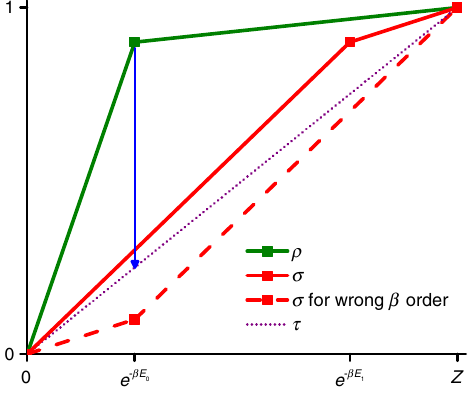
FIG. 7. Partial level thermalizations are not enough. Note that PLTs alone cannot implement all transitions possible under thermal operations. More specifically, they cannot implement changes of β order on qubits. In this above example, we see that a PLT cannot take the initial state ρ depicted in green to σ depicted in red, because it first passes through the thermal state before it reaches σ (which we have depicted in both its β -ordered and non- β -ordered form). Because of this, work is required to go from ρ to σ even though the optimal process does not require